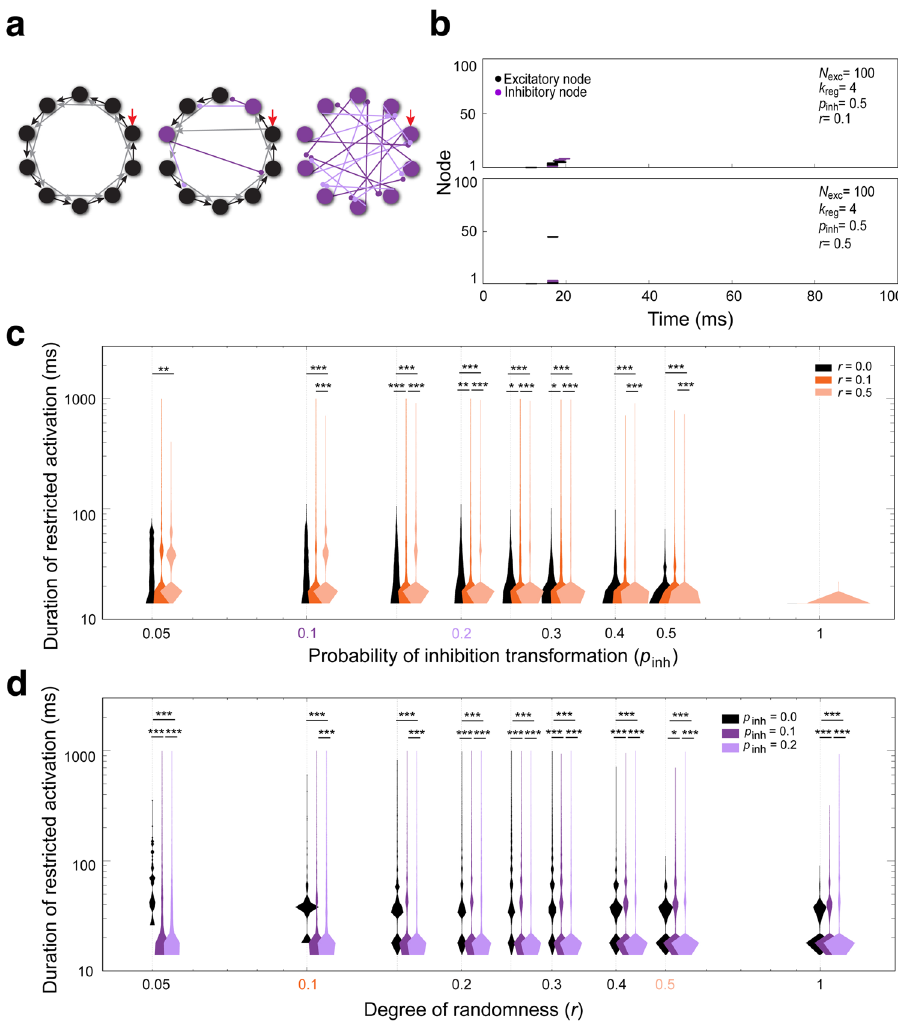
Figure 5. Random assignment of excitatory and inhibitory nodes combined with random rewiring of connections between nodes enhances the encoding capacity of a network. ( a ) Diagram depicting random assignment of excitatory and inhibitory nodes in the basic regular network with different degrees of randomness in network rewiring. Left : basic regular network structure, in which p inh = 0 and r = 0. Middle : one edge of an excitatory node and an inhibitory node were rewired, respectively. As p inh increases, increasing numbers of nodes are assigned as inhibitory. Right : when p inh = 1 and r = 1, all nodes are inhibitory and all edges are rewired randomly. ( b ) The dynamics of network activation are shown as spike raster plots. When a node is transformed from excitatory to inhibitory, its color code is switched from black to magenta. Note that when p inh = 0.5, r = 0.1, some simulated networks show ceased activation shortly after stimulation ( top ). Similar results were also observed in a network structure with p inh = 0.5, r = 0.5 ( bottom ). ( c ) Excitatory nodes were randomly assigned to be transformed to inhibitory nodes in the basic regular network ( N exc = 100, k reg = 4) at different degrees of randomness ( r = 0 (black), 0.1 (orange) and 0.5 (light orange)). The distribution of restricted activation duration at a given p inh is shown as a violin plot. Significance was assessed with Mann–Whitney U -test. Statistically significant differences are indicated; * p < 0.05, ** p < 0.01, *** p < 0.001 (see Table S3). ( d ) Three distinct networks with p inh = 0 (black), 0.1 (magenta), or 0.2 (light magenta) were examined. The distribution of restricted activation duration is shown as a violin plot. Significance was assessed with Mann–Whitney U -test. Statistically significant differences are shown; * p < 0.05, ** p < 0.01, *** p < 0.001 (Table